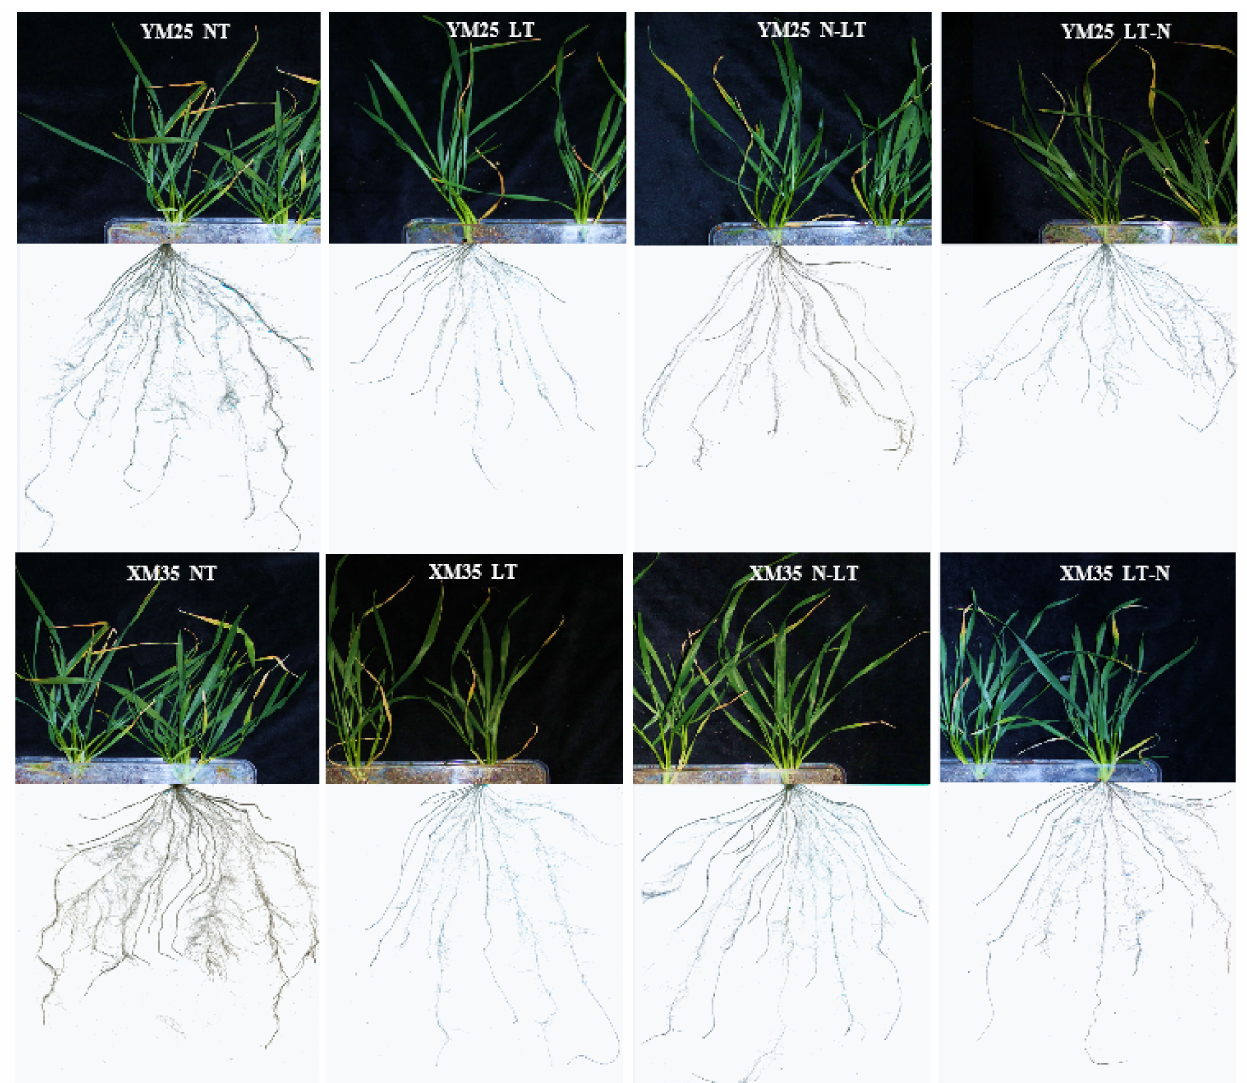
Figure 2. Plant morphology under NT, LT, N-LT and LT-N treatments on the 21st day post low- temperature stress. NT, Normal temperature control; LT, Low-temperature treatment at 4-leaf stage; N-LT, Application of 15 N urea prior to low temperature at 4-leaf stage; LT-N, Application of 15 N urea post low temperature at 4-leaf